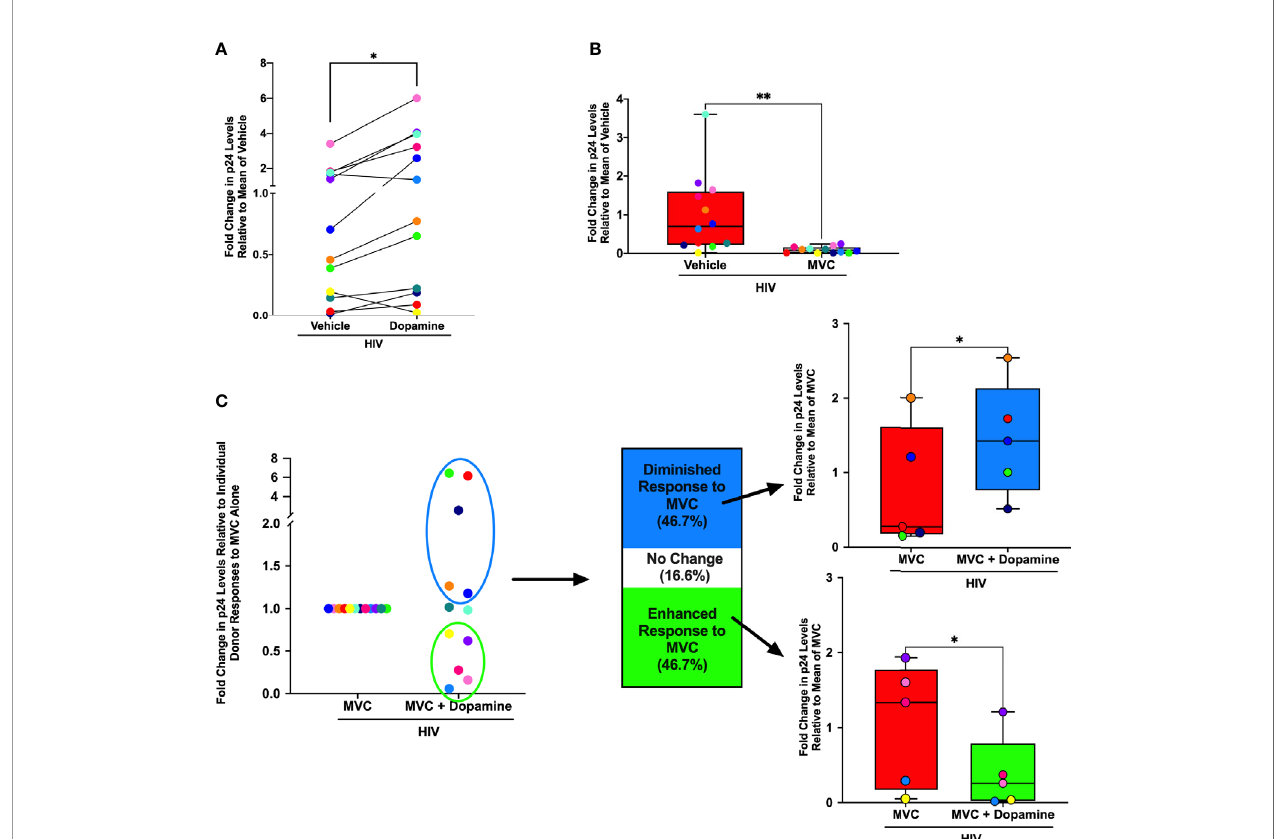
FIGURE 1 | Dopamine Alters Effectiveness of Maraviroc in HIV-infected hMDM. Primary human monocyte-derived macrophages (hMDM) from twelve donors were inoculated with HIV ADA (0.5 ng/mL) for 24 hours in the presence of vehicle (diH 2 O or DMSO), a dopamine (10 -6 M) condition maraviroc (MVC) (0.1 µM) or MVC + dopamine (10 -6 M). Infections were maintained in culture for 3 days, at which point supernatants were collected and examined for levels of HIV replication (p24). Responses from each donor are designated with a speci fi c color throughout. (A) When examining fold change in p24 levels relative to the mean of vehicle treatment, dopamine signi fi cantly increased HIV infection alone (Paired t-test, n = 12, *p = 0.0162, t=2.835, df=11). (B) When examining fold change in p24 levels relative to the mean of vehicle treatment, MVC also successfully suppressed viral replication at 0.1µM, in that MVC signi fi cantly decreased p24 levels relative to HIV alone (Paired t- test, n = 12, **p = 0.008, t=3.229, df=11). (C) When examining fold change in p24 levels relative to individual donor responses to MVC treatment alone, there was a bimodal response to dopamine in hMDM treated with 0.1 µM MVC. Compared to the p24 levels relative to the mean of MVC alone, fi ve out of twelve donors (46.7%) showed a dopamine-mediated diminished response to MVC (Paired t-test, n = 5, *p = 0.0391, t=3.021, df=4), and fi ve out of twelve donors (46.7%) showed a dopamine-mediated enhanced response to MVC (Paired t-test, n = 5, *p = 0.049, t=2.796, df=4). Two of the twelve donors (16.6%) showed no response to dopamine in respect to the ef fi cacy of